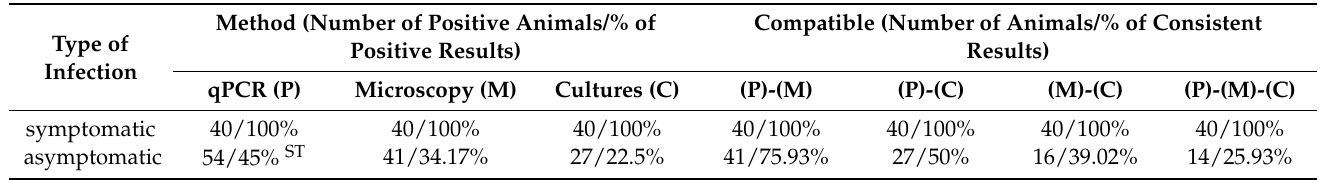
Table 2. Diagnostic effectiveness of tested methods in relation to clinical material taken from symptomatic and asymptomatic dermatophyte